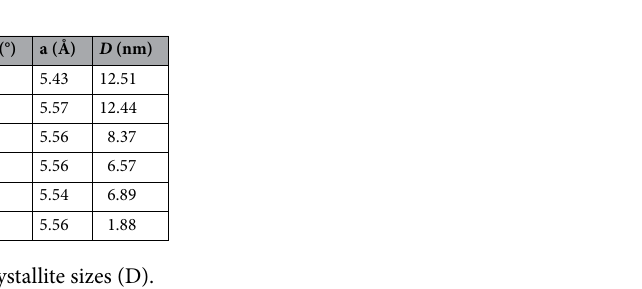
Table 1. Debye–Scherrer mean crystallite sizes